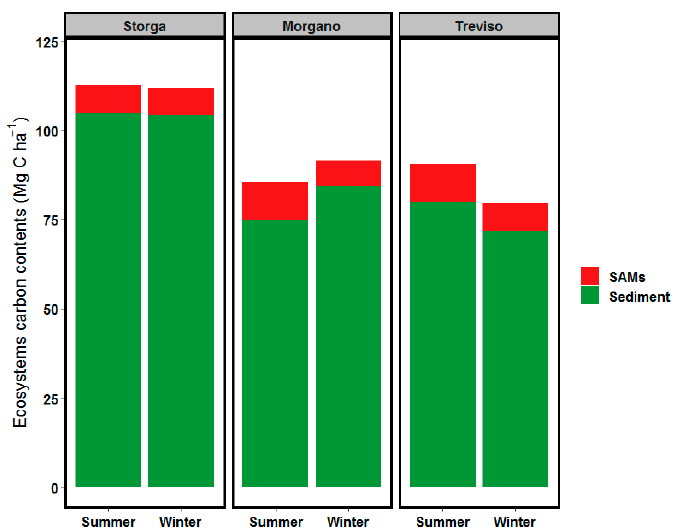
Figure 4. Distribution of ecosystem carbon stock for Sile River sampling stations.